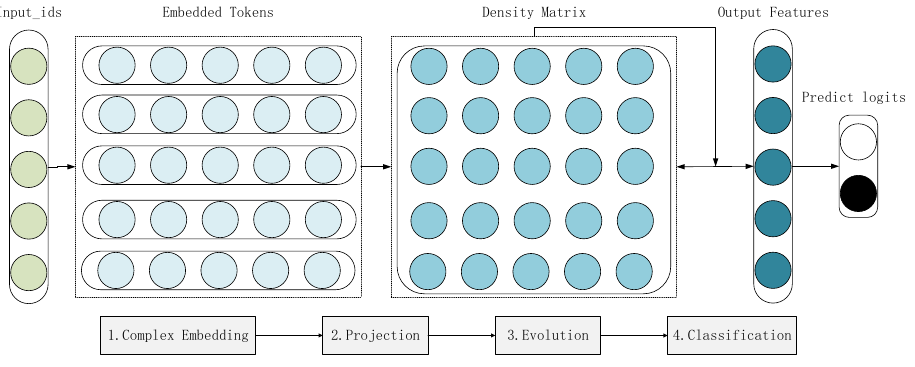
Figure 3. The architecture of the